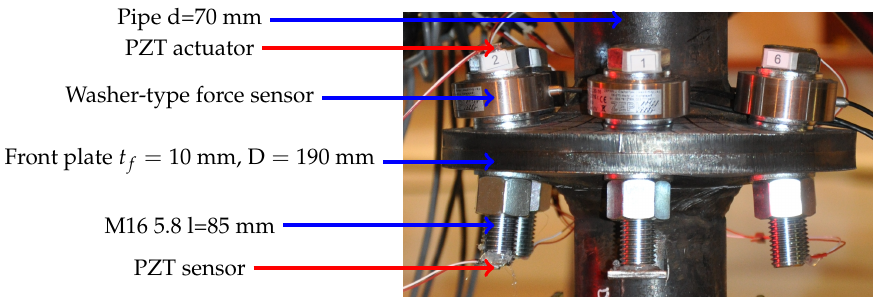
Figure 2. An example of visible bolts deformation at the end of the static test (P6